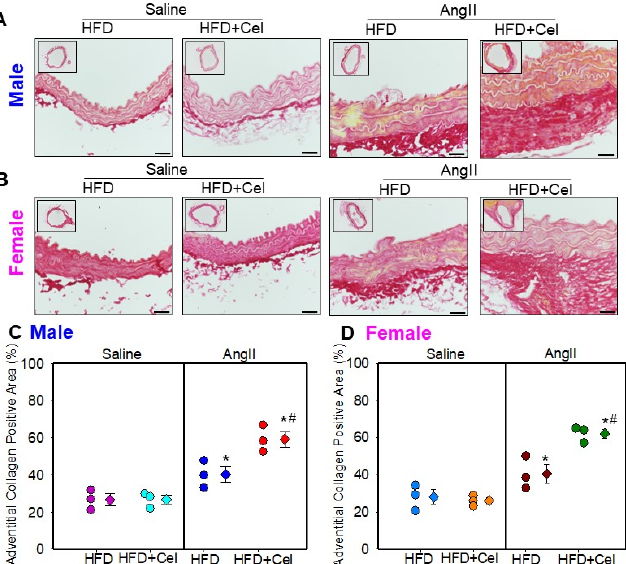
Figure 6. Representative suprarenal aortic tissue sections from saline or Ang II (500 or 1000 ng/kg/min) infused male ( A ) and female ( B ) mice supplemented with high fat diet +/ ‐ Celastrol stained with Picrosirius red stain. Scale bars correspond to 50 μ m. Measurements of adventitial col ‐ lagen positive area (Male—( C ); Female—( D )) in the cross ‐ sections of abdominal aortas ( n = 3 in each group). Male—purple (saline + HFD), teal (saline + Cel), blue (AngII + HFD), and red (AngII + HFD + Cel) and Female—blue (saline + HFD), orange (saline + Cel), brown (AngII + HFD), and green (AngII + HFD+ Cel) circles represent individual mice, diamonds represent means, and bars are SEMs. * Denotes p < 0.05 when comparing saline vs. AngII infusion; # p < 0.05 AngII + HFD vs. AngII + HFD + Cel (two ‐ way ANOVA with Holm–Sidak post hoc analysis). AngII: angiotensin II, HFD: high ‐ fat diet, Cel: Celastrol.